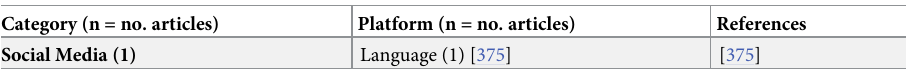
Table 28. Number of articles predicting social class, with associated predictors and